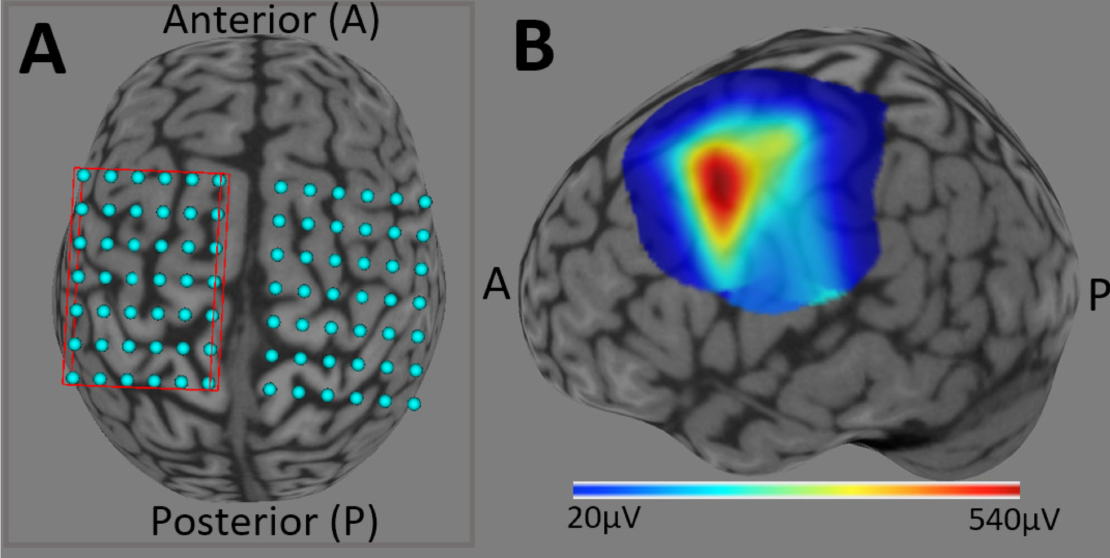
Figure 3. Finding the Hotspot and Creating a Motor Map. Guided using neuronavigation software, a 6 cm × 7 cm grid is placed on the motor area to assist with finding the first dorsal interosseous primary motor area representation corresponding to the right hand ( A ). Blue dots (12 mm apart) represent the pre-determined targets in which the experimenter performed 2–3 transcranial magnetic stimulation (TMS) stimulations. ( B ) A “heat map” is built using the neuronavigation software (Brainsight, Rogue Research Inc, Montreal, QC, Canada) demonstrating the primary motor area’s first dorsal interosseous muscle representation from a single multiple sclerosis (MS) participant (female, 31 years-old, presenting with no disability [expanded disability status scale (EDSS)